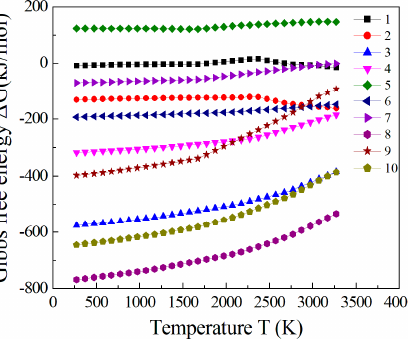
∆ G values at different temperatures for different Figure 3. Gibbs free energy Δ G values at different temperatures for different reactions. Figure 3. Gibbs free energy